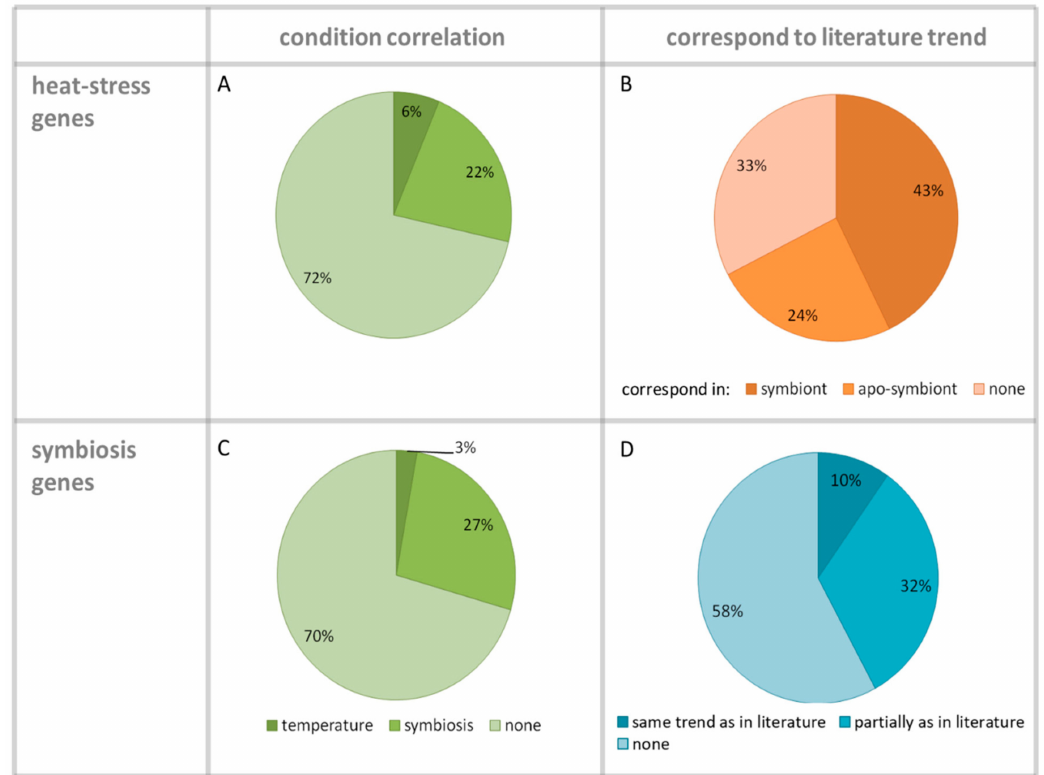
Figure 4. Condition correlation and correspondence with literature trend of “heat-stress genes” and “symbiosis genes.” Percentages are shown out of the total identified 126 and 71 genes of heat stress and symbiosis, respectively. ( A , C ) Percentage of genes categorized by the condition (temperature / symbiosis) correlation regarding “heat-stress genes” and “symbiosis genes,” respectively. A gene with a fold change trend similar in 28S–28AS and in 31S–31AS was defined as: “temperature-correlated,” while a gene with a fold change trend similar in 28S–31S and in 28AS–31AS, was termed: “symbiosis-correlated.” ( B ) Percentage of “heat-stress genes” that corresponded to the trend in the literature for symbiont and apo-symbiont treatments. ( D ) Percentage of “symbiosis genes” that followed the trend as described in the literature. When just one symbiotic or apo-symbiotic sample followed the trend, it was defined as ‘partially as in